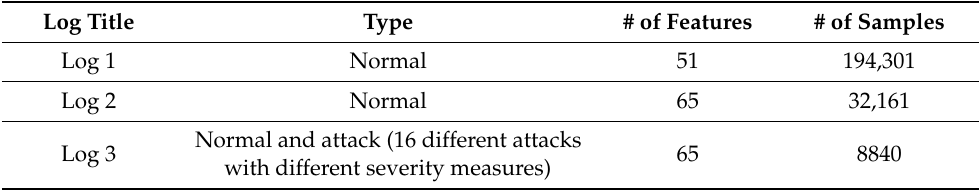
Table 2. Log file details in the HVAC system dataset.